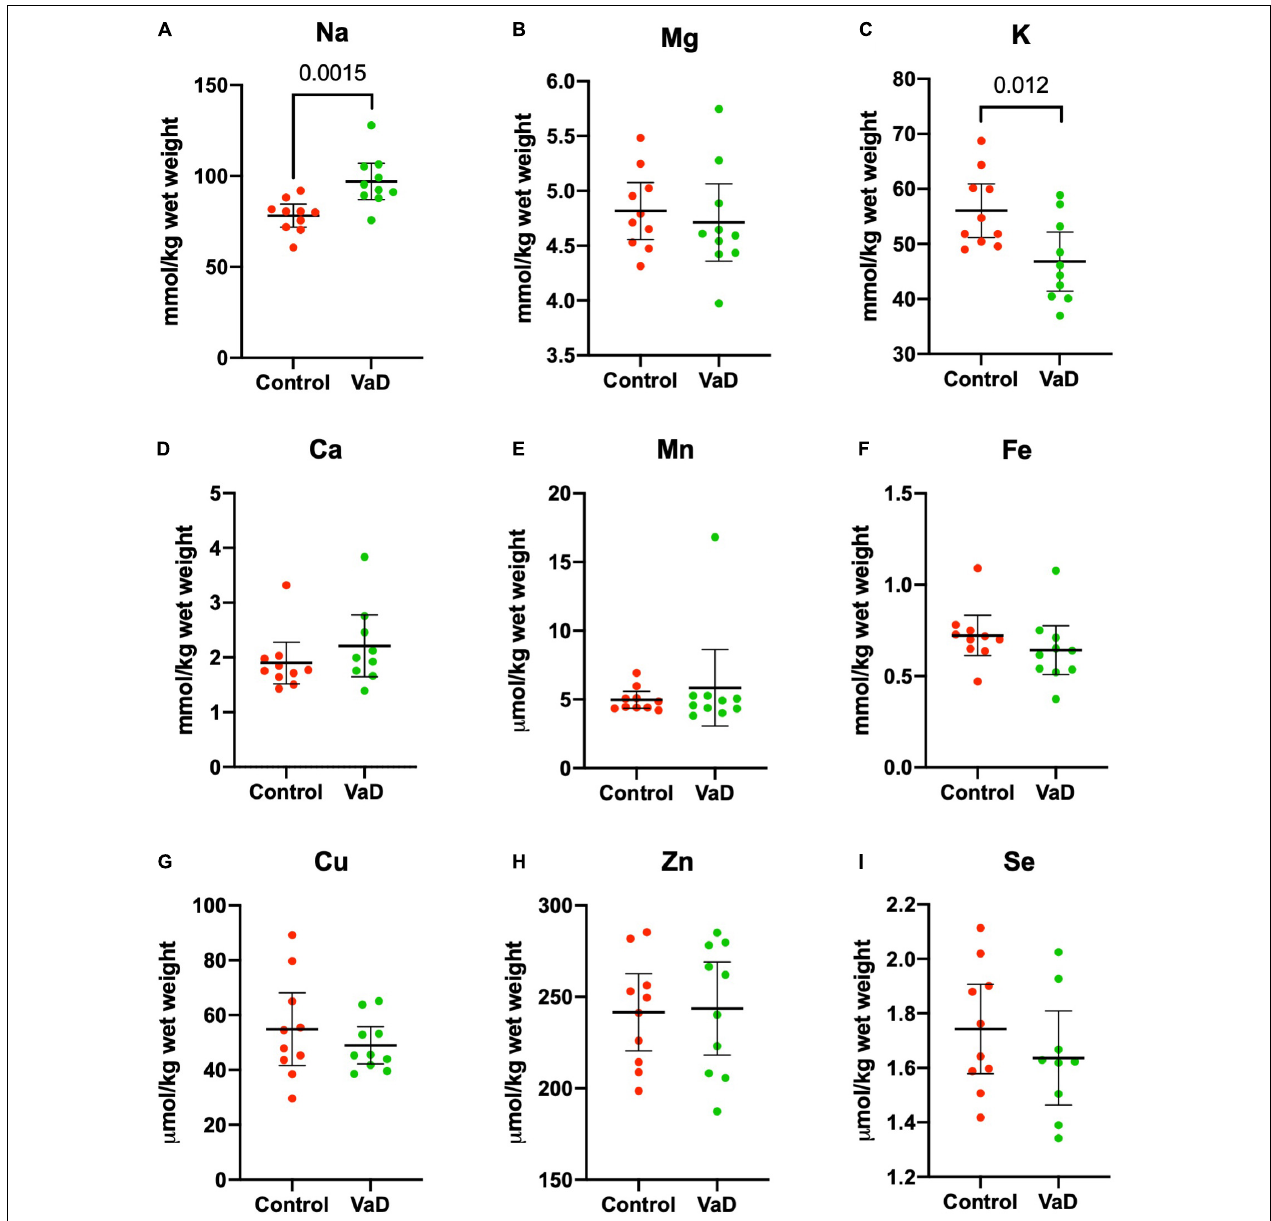
FIGURE 1 | Wet-weight concentrations of nine essential elements (A–I) in the hippocampus compared between control (red) and VaD (green) post-mortem human tissue. Data shown represent elemental means ± 95% CI from control ( n = 10) and VaD ( n = 10) brain. A single outlier from each of Ca and Se datasets was removed from the plot for clarity. n = number of post-mortem human